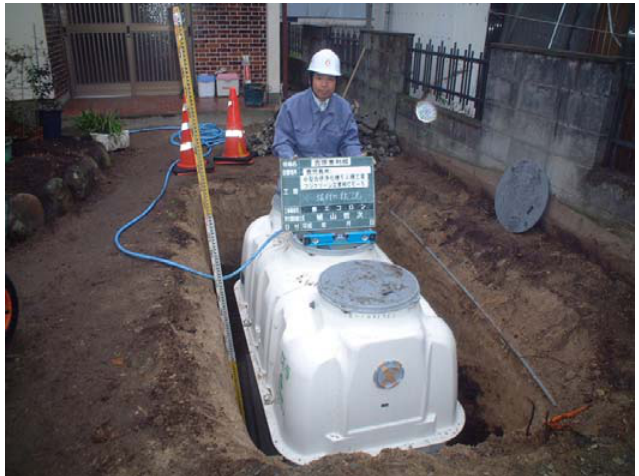
Figure 9. Individual septic tank for both human waste and gray water [31]. Tanks are buried on each household’s